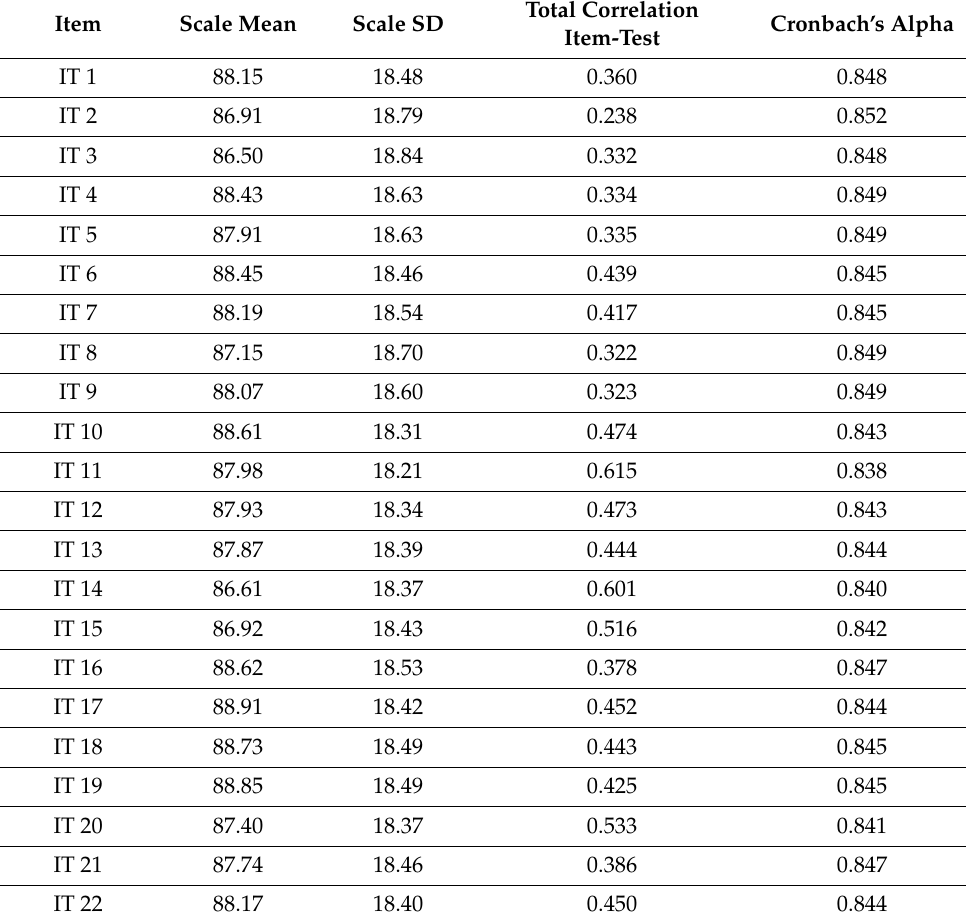
Table 1. Statistics for the items comprising the final version of the TSOC. Item Scale Mean Scale